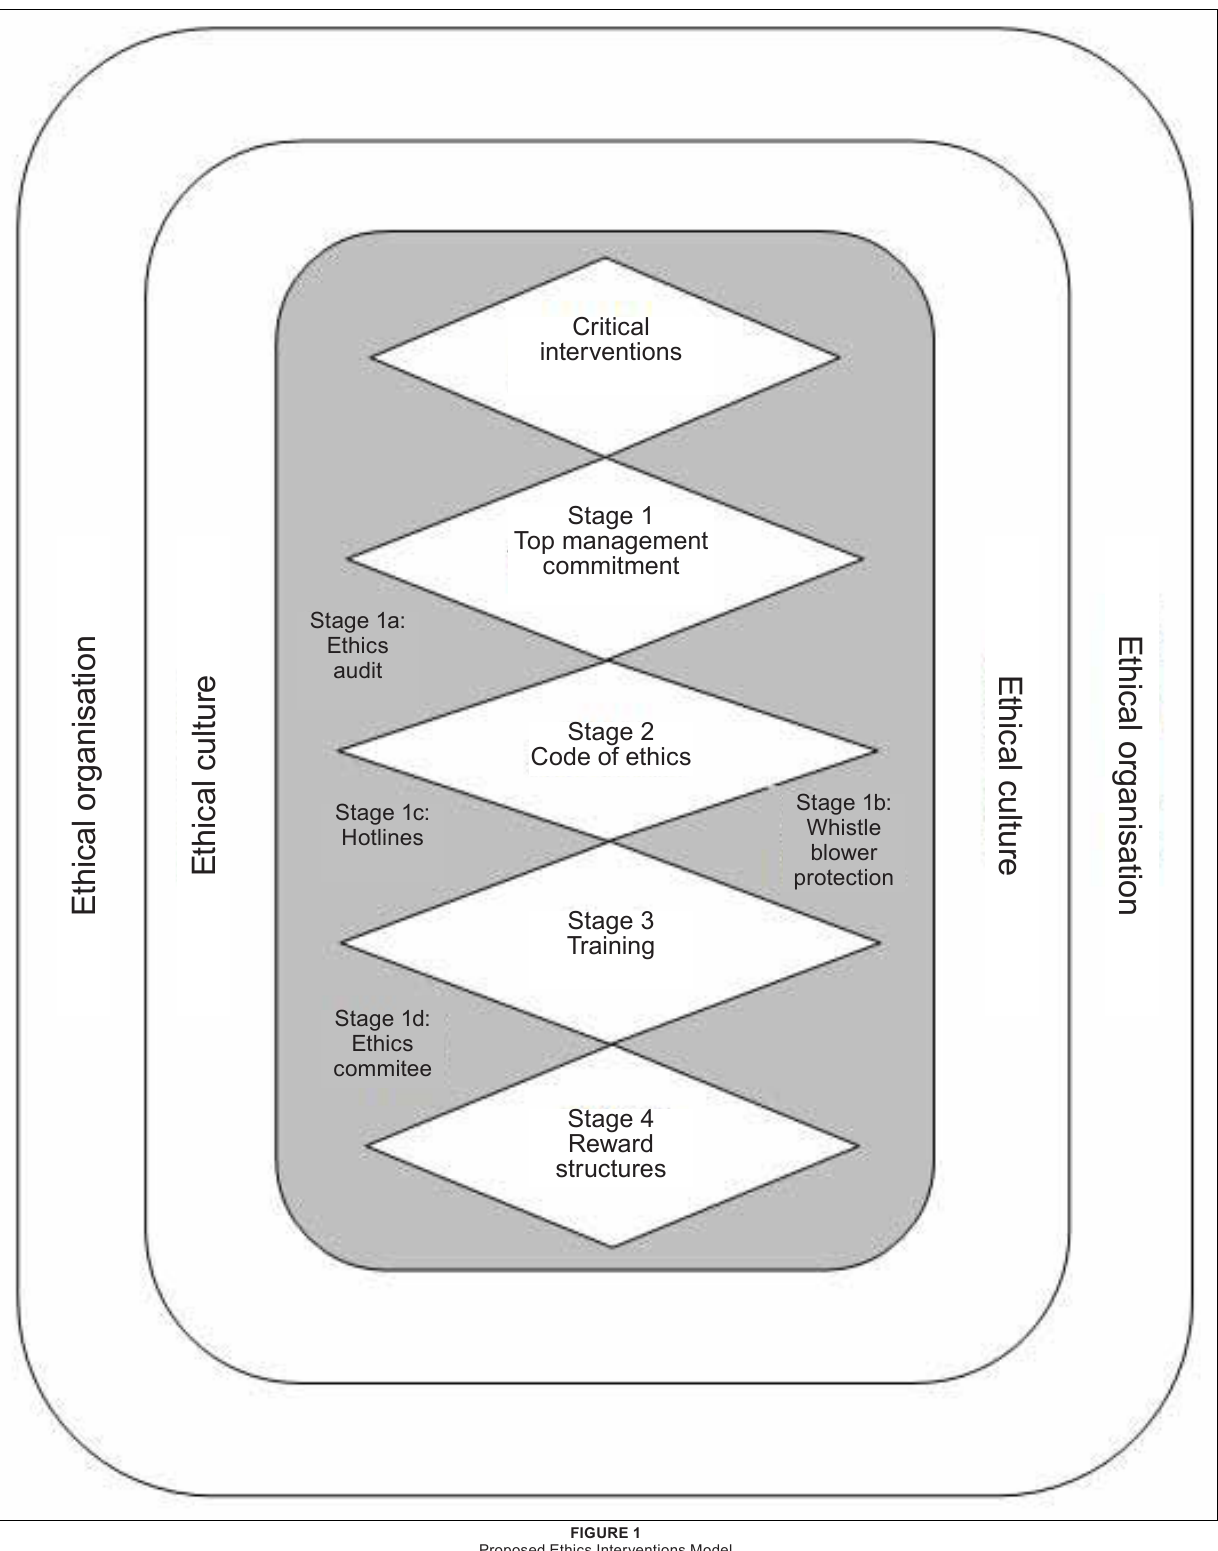
FIGURE 1 Proposed Ethics Interventions